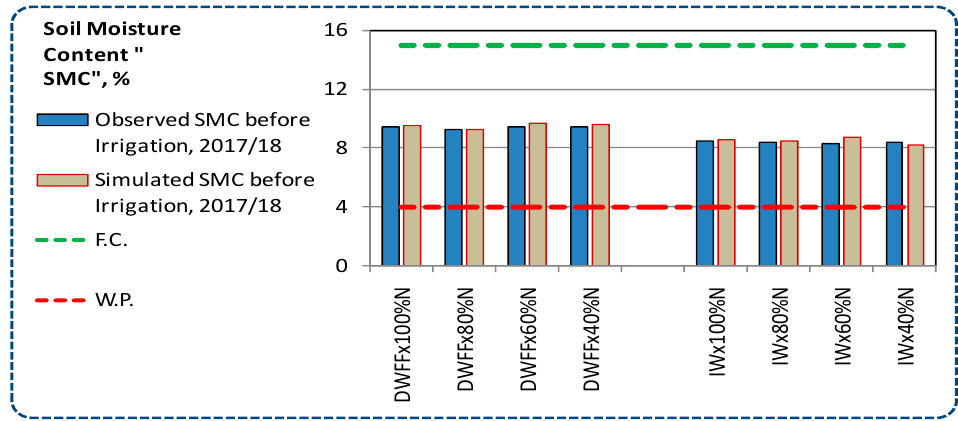
Figure 3. Effect of water quality and fertigation rate of nitrogen on the soil moisture content before irrigation at peak during the 2017/2018 growing season compared with the simulated soil moisture content for all treatments: drainage water from fish farms (DWFF), fresh irrigation water (IW) and nitrogen (N).